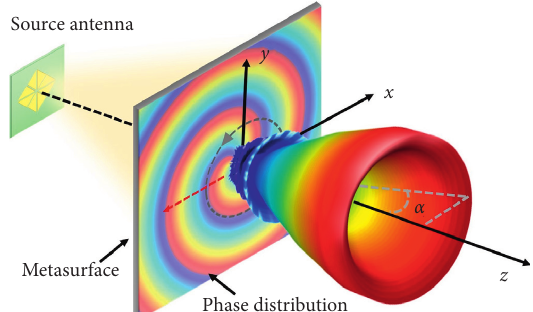
Figure 1: Schematic of the proposed transmissive metasurface. The primary radiation from a patch antenna is reshaped into a conical radiation when it passes through the proposed metasurface through a predesigned transmission phase pattern. The red and gray dotted lines on the metasurface denote the radial and circumferential directions,